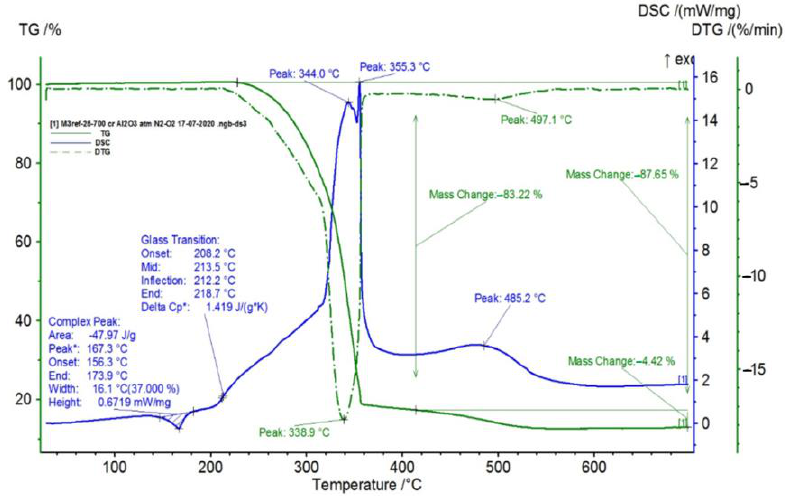
Figure 6. TG/DSC variation for sample M2.